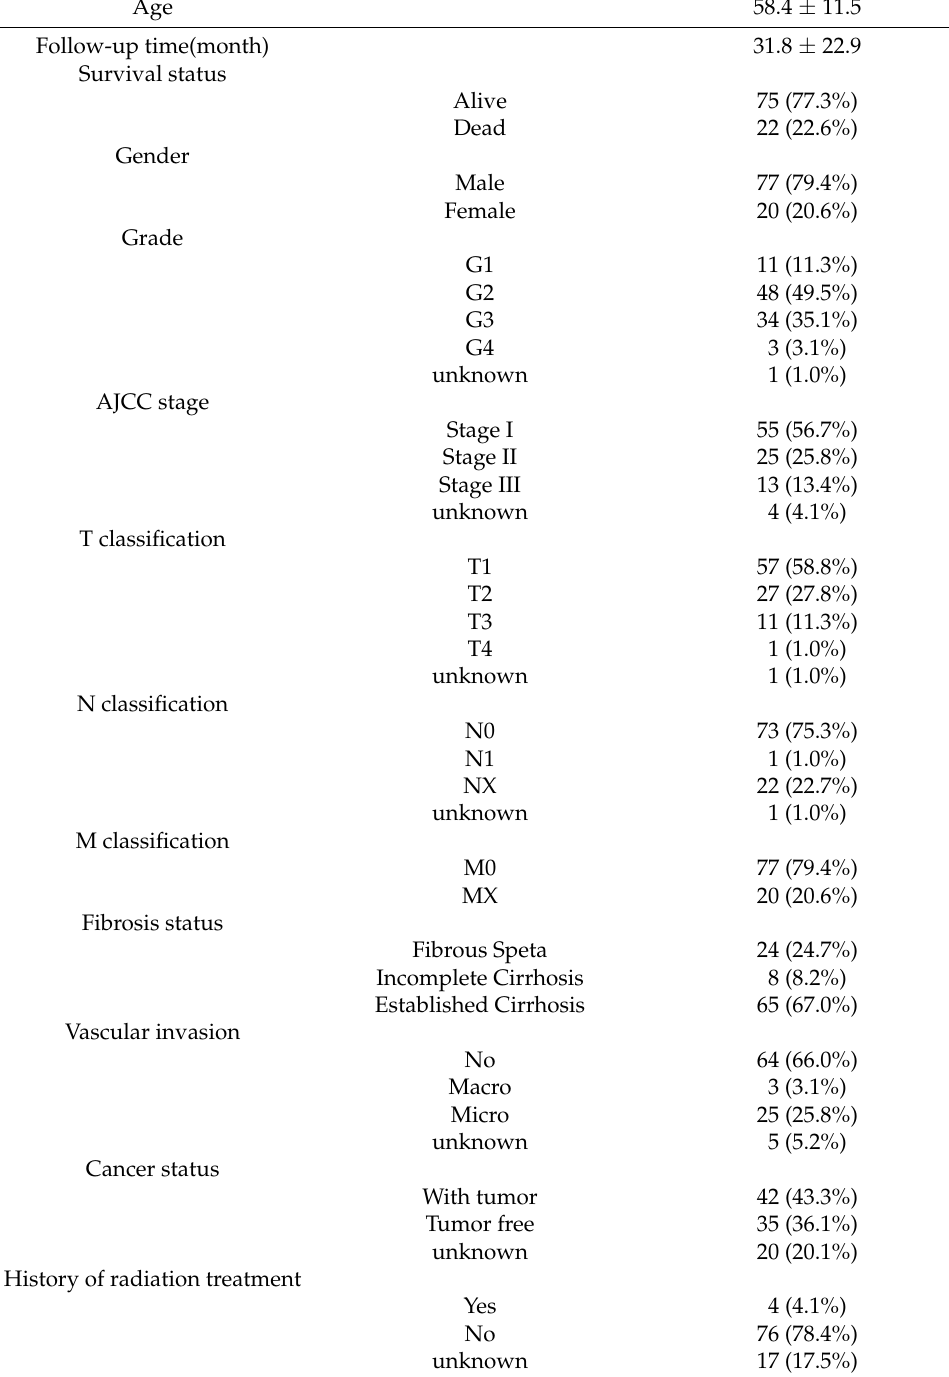
Table 1. Clinical features of selected TCGA-LIHC